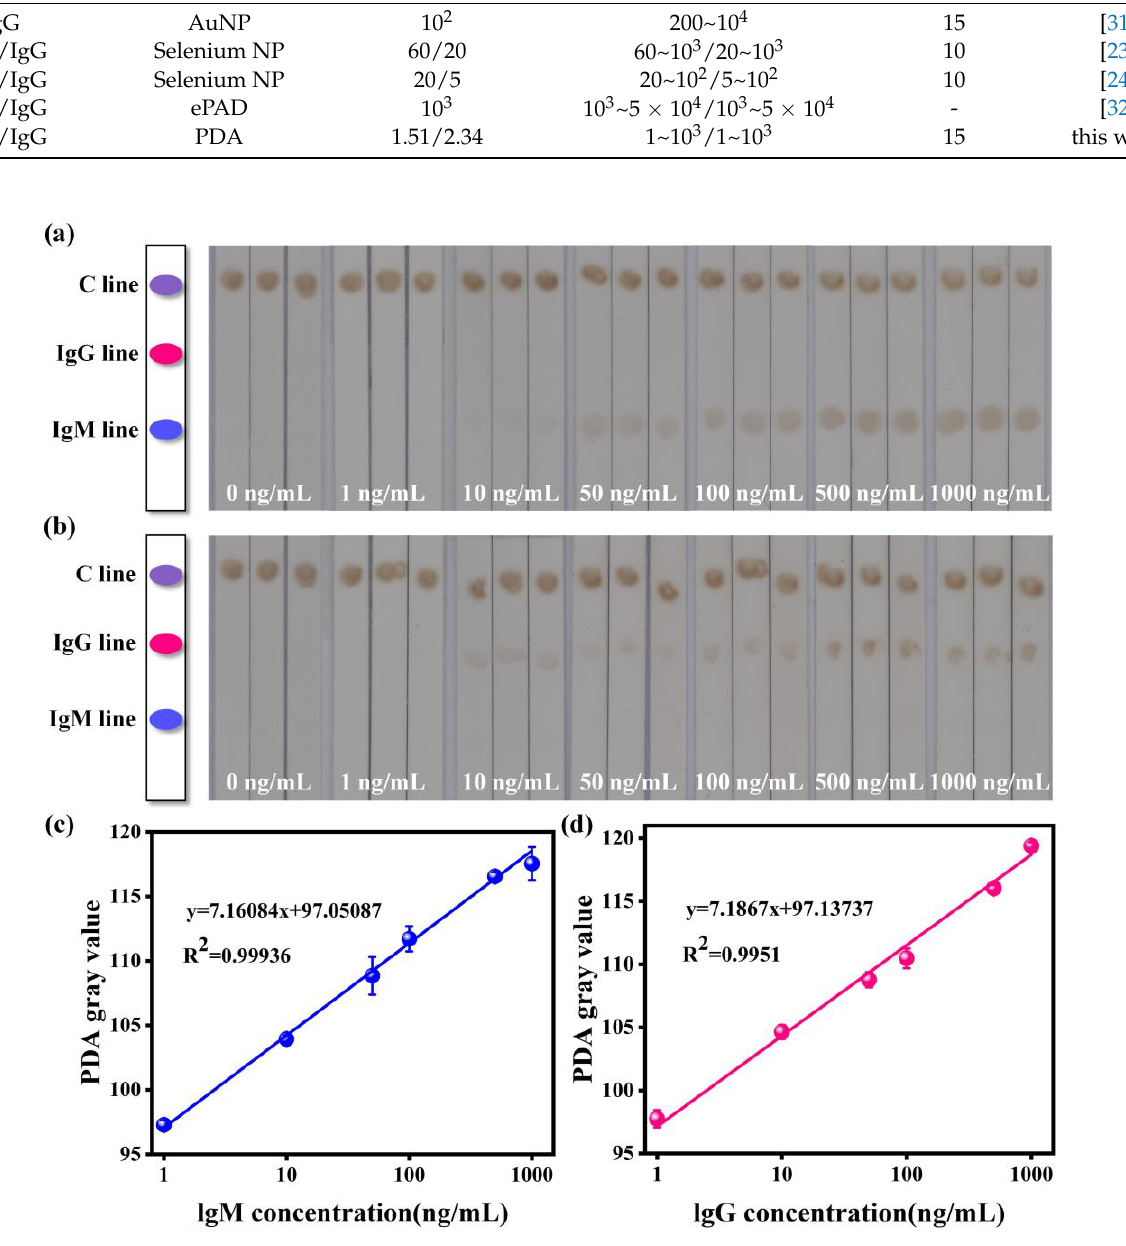
Figure 3. Standard curves of PDA-based three-line LFIA for COVID-19 IgG and IgM. ( a ) The images of the PDA-based three-line LFIA for COVID-19 IgG at different concentrations. ( b ) The images of the PDA-based three-line LFIA for COVID-19 IgM at different concentrations. ( c ) The standard curve of the PDA-based three-line LFIA for COVID-19 IgG at different concentrations. ( d ) The standard curve of the PDA-based three-line LFIA for COVID-19 IgM at different concentrations.